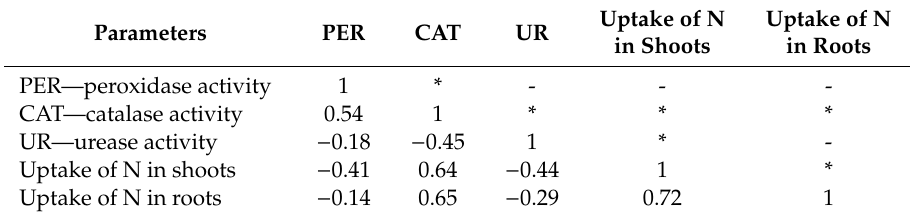
Table 5. Correlation